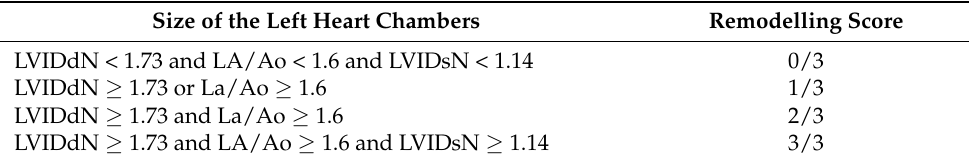
Table 2. Remodelling score